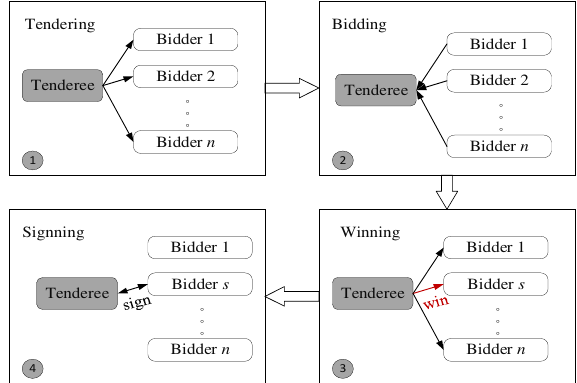
Figure 2. The main idea of CNP.